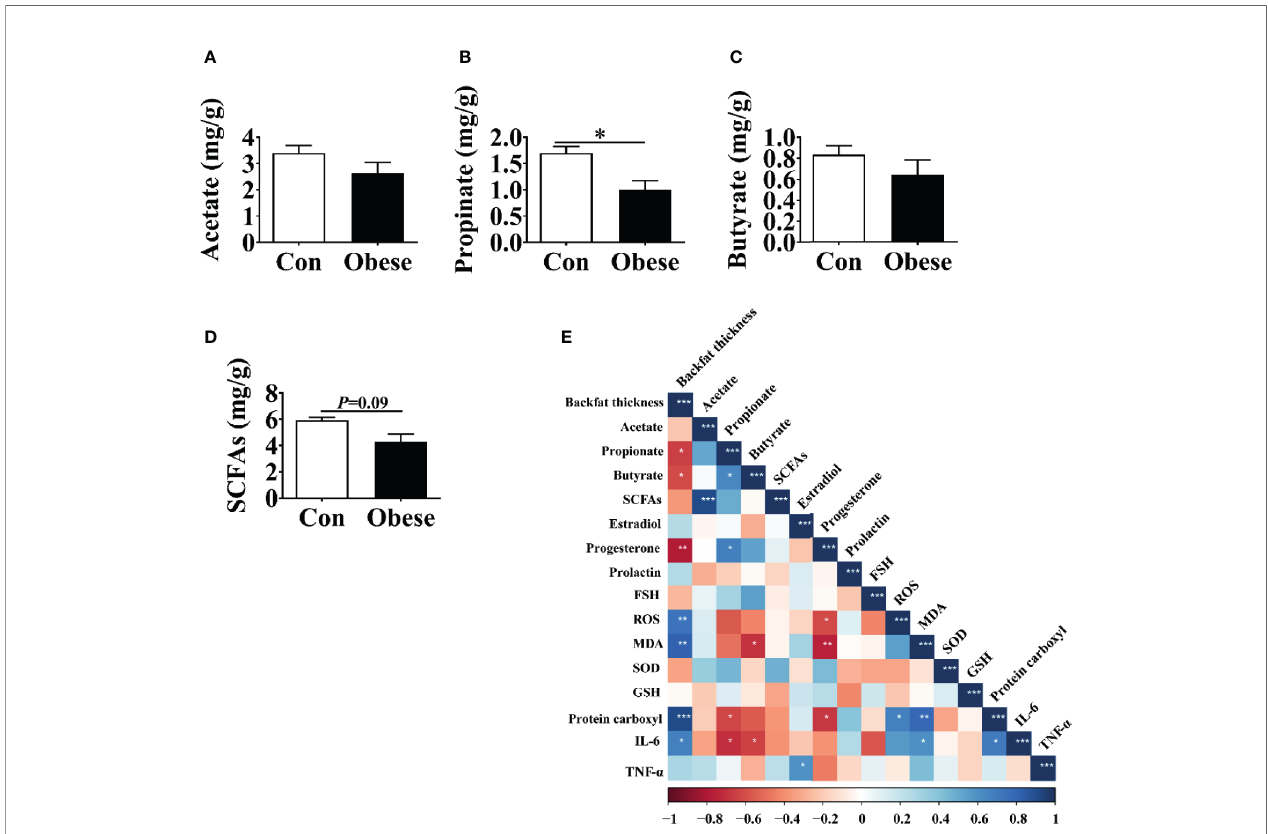
FIGURE 5 | The concentrations of SCFAs in the feces of gilts. (A – D) Fecal acetate, propionate, and butyrate concentrations, respectively. (E) Correlation analysis of serum hormone, placental immune marker, antioxidant indexes, and fecal SCFAs levels. Data represent the means ± SEM. “ * ” , “ ** ” , and “ *** ” indicate P < 0.05, < 0.01, and < 0.001,